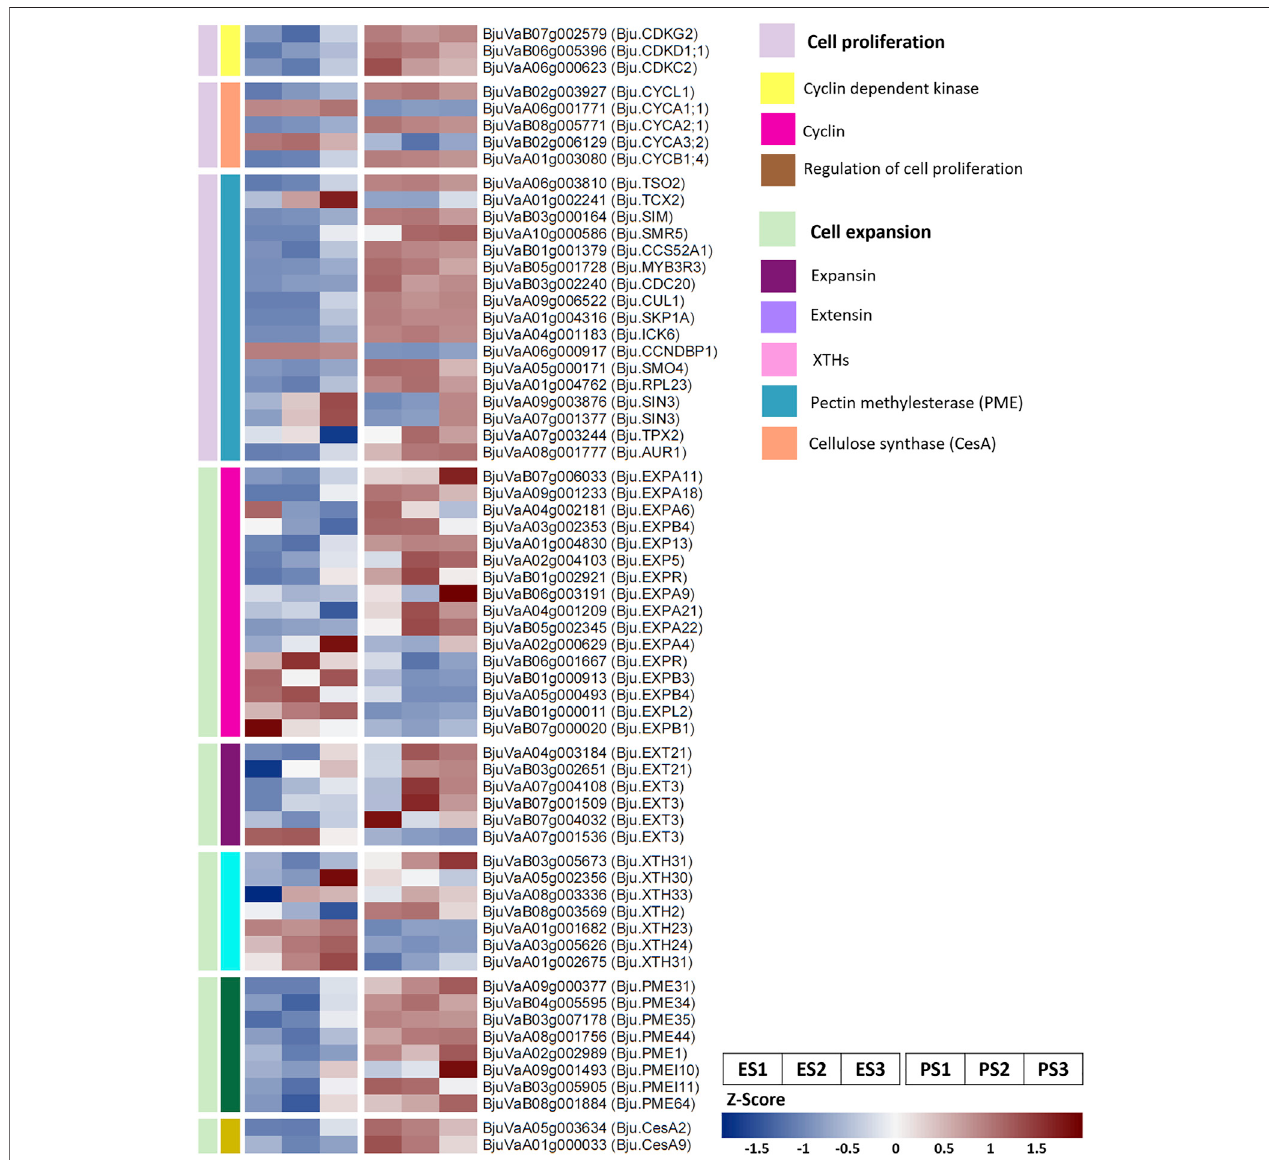
FIGURE 3 | SelecteddifferentiallyexpressedgenesinEH-2andPJforregulationofcellproliferationandcellexpansion.E,EH-2;P,PJ;S1 – S3,seeddevelopmentstages.